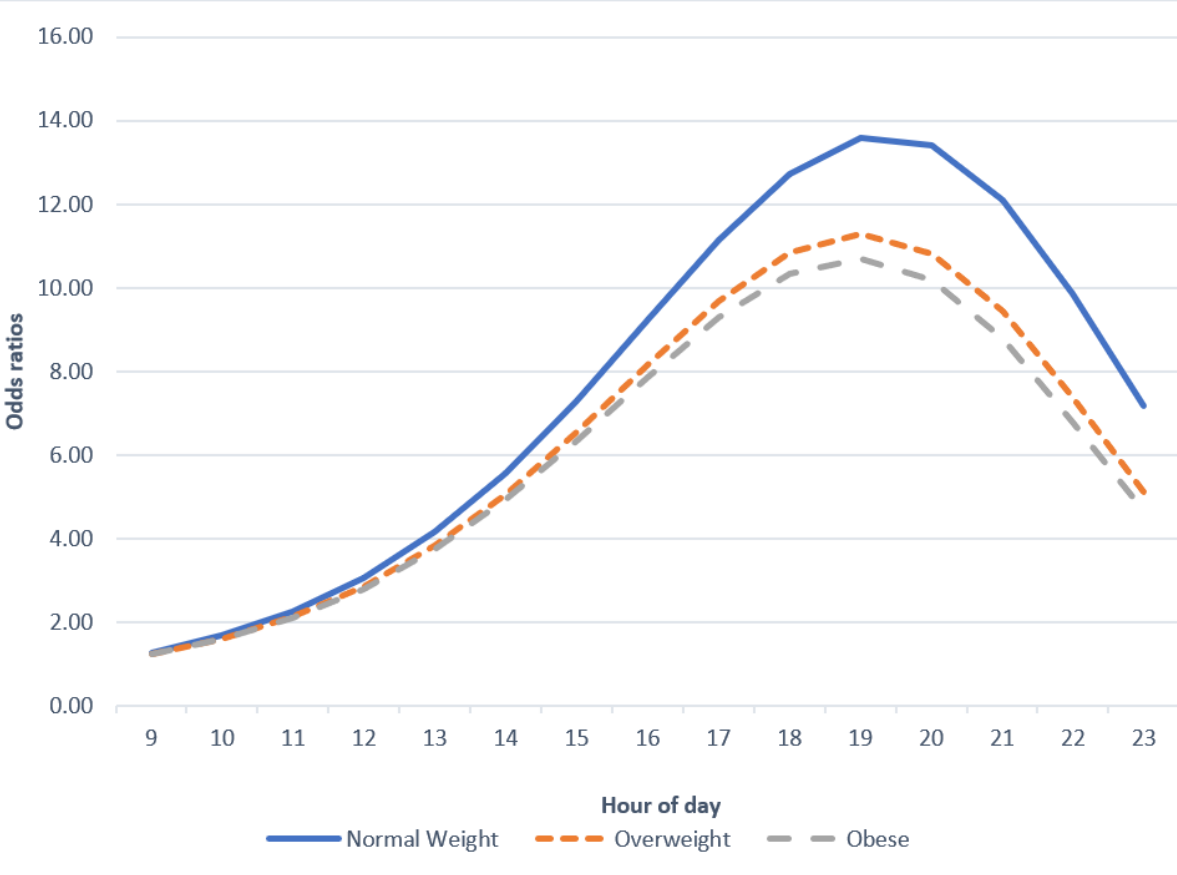
Figure 3. BMI differences in odds ratios of obtaining average moderate-to-vigorous physical activity before each hour of day.